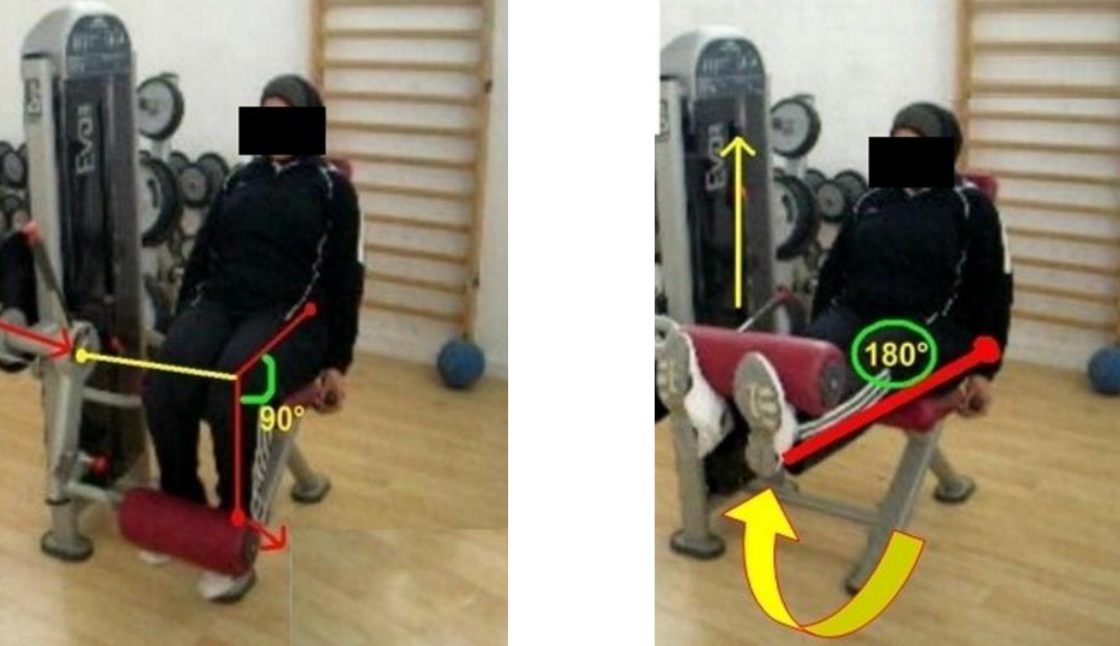
Figure 1. 1-RM prediction of knee extensor muscles.